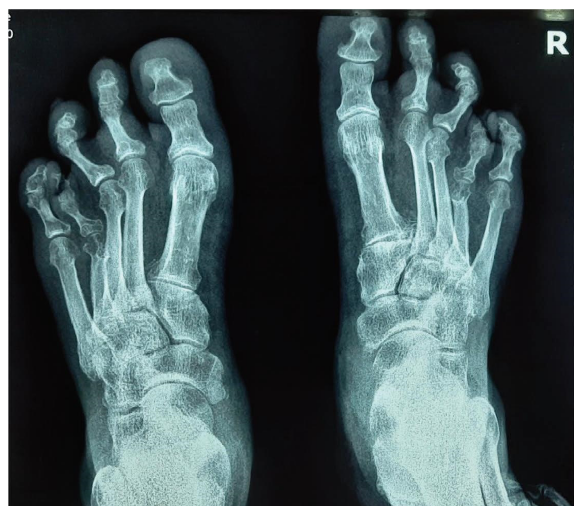
Figure 5: X-ray of bilateral feet showing brachymetatarsia.